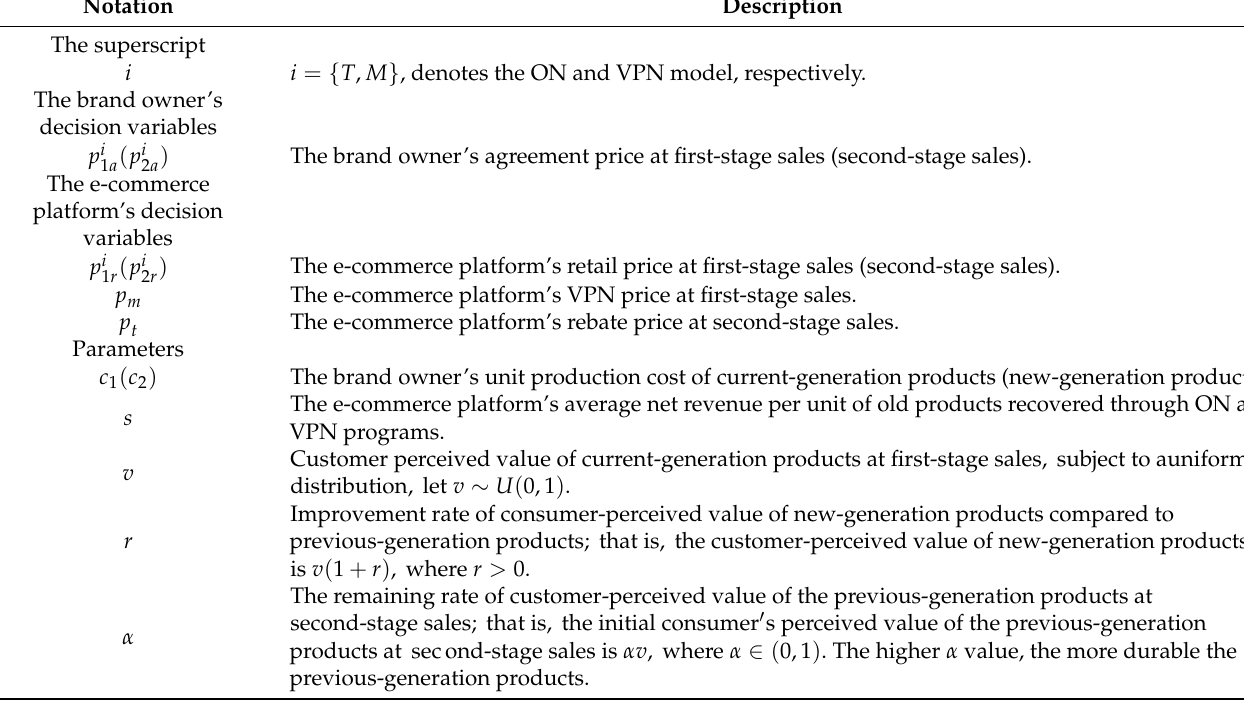
Table 1. Summary of notations.